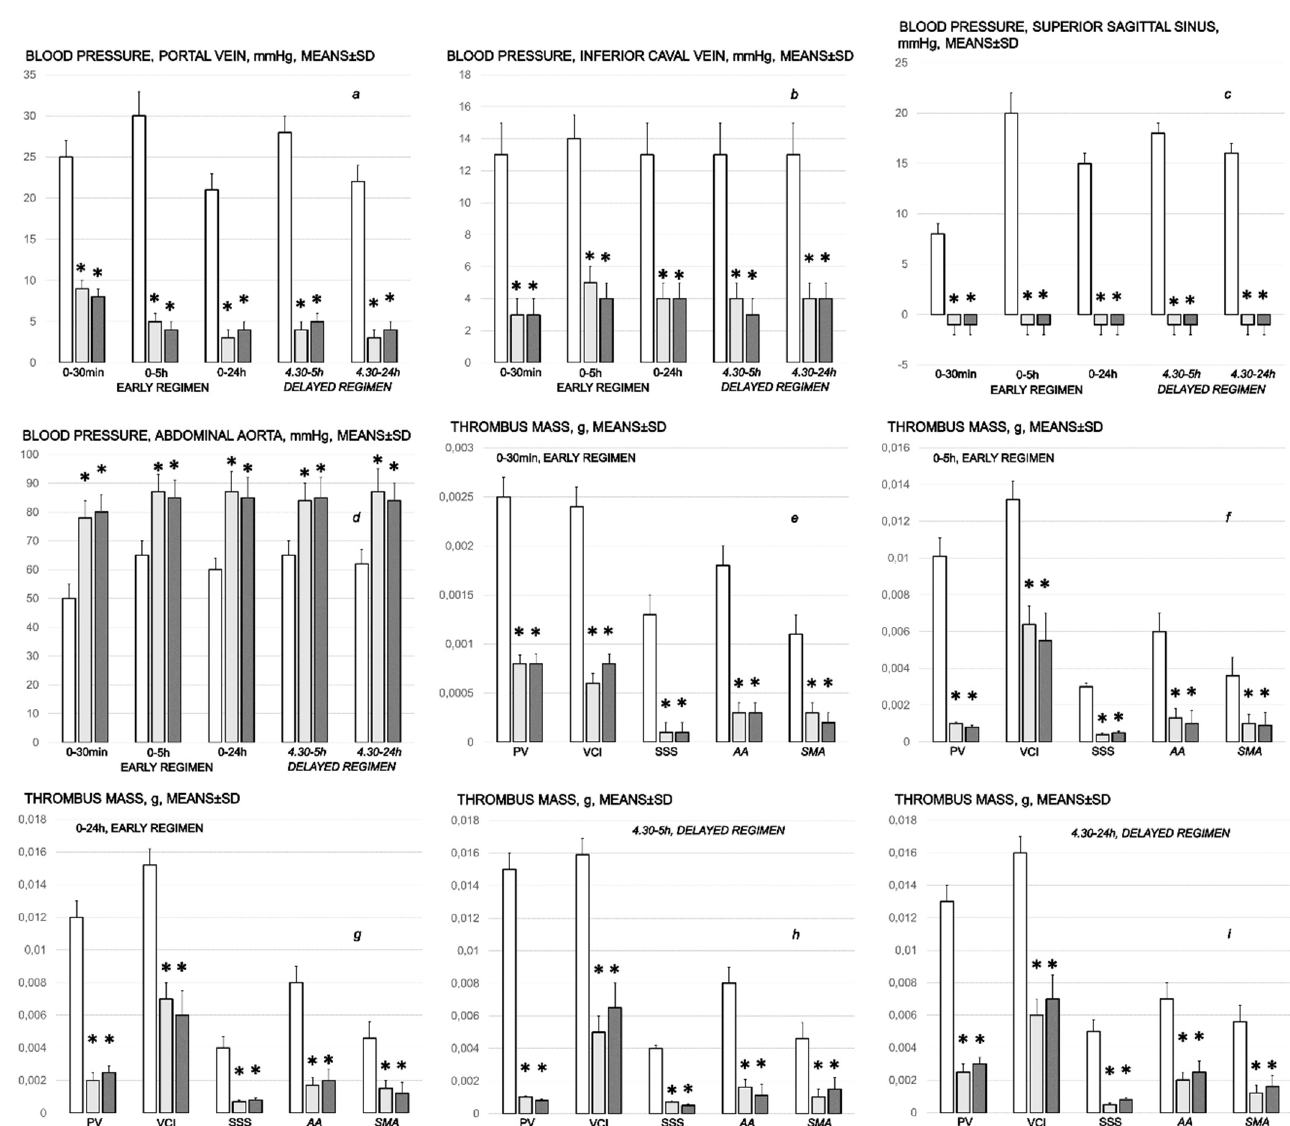
Figure 1. Blood pressure assessment, portal ( a ), caval ( b ) and intracranial (superior sagittal sinus) ( c ) hypertension, and aortal hypotension ( d ) in mmHg at the end of the ligation time period of 30 min, 5 h, and 24 h. Timeline of the thrombosis development in portal vein (PV), inferior caval vein (ICV), superior sagittal sinus (SSS), abdominal aorta (AA) and superior mesenteric artery (SMA) at the end of the ligation time period of 30 min, 5 h, and 24 h, as an early regimen at 0–30 min ( e ), 0–5 h ( f ), and 0–24 h ( g ) application-sacrifice period, and as delayed regimen at 4.30 h–5 h ( h ) and 5 h–24 h ( i ) application-sacrifice period. Therapy included BPC 157 (10 µ g/kg (light gray bars) or 10 ng/kg (dark gray bars)) or saline (5 mL/kg) (white bars) as an intragastric administration either immediately following ligation, or as an early regimen, for assessment at 30 min, 5 h and 24 h-ligation time. As a delayed regimen, the therapy was given as an intragastric administration at 4.30 h ligation time for assessment at 5 h ligation time, or as oral administration, continuously in drinking water from 5 h ligation time until sacrifice at 24 h ligation time. Means ± SD, * p < 0.05, at least, vs.